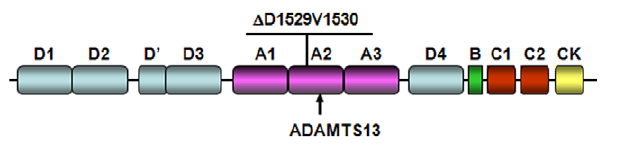
Figure 3. Identification of a VWF gene mutation. Sequence analysis of the VWF gene in the proband detected a 6-bp nucleotides deletion in exon 28. The mutation caused D1529V1530 deletion ( D D1529V1530) in VWF A2 domain. The ADAMTS13 cleavage site is indicated by an arrow.